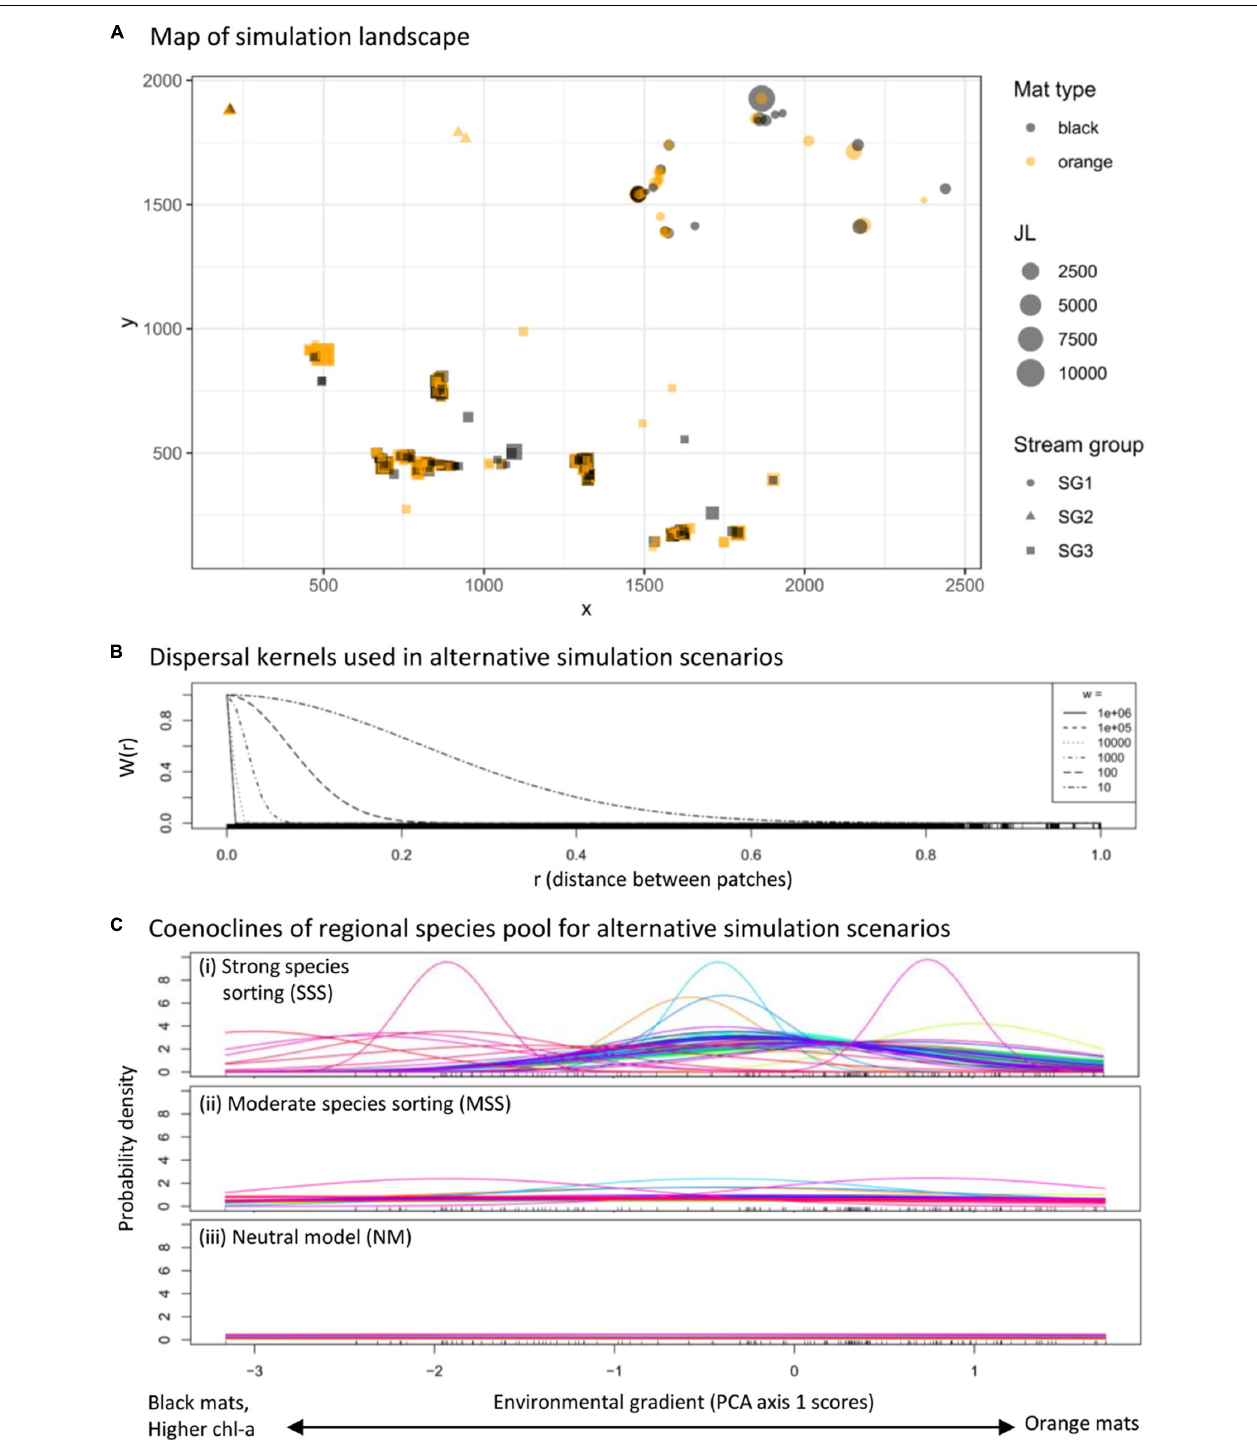
FIGURE 4 | All metacommunity simulations used the same map, where J L indicates community size at each patch, x- and y- axes indicate patch coordinates in pixels, which are the spatial units used in the simulation and correspond to a ∼ 2 m × 2 m area in the original raster map (A) , each simulation scenario was randomly assigned one of the dispersal kernels (see Eq. 2) plotted in (B) , and included species habitat preferences and niche breadths resulting in different types of metacommunity dynamics: (C-i) , where C niche = 1, strong species sorting (SSS); (C-ii) , where C niche = 4, moderate species sorting (MSS); or (C-iii) , where C niche = 20, neutral model (NM). The “rug” (upward ticks along the x -axis) in (B) indicates all the pairwise distances between patches in the simulation landscape, and the “rug” in (C) is the distribution of patches along the environmental gradient used in the simulation.